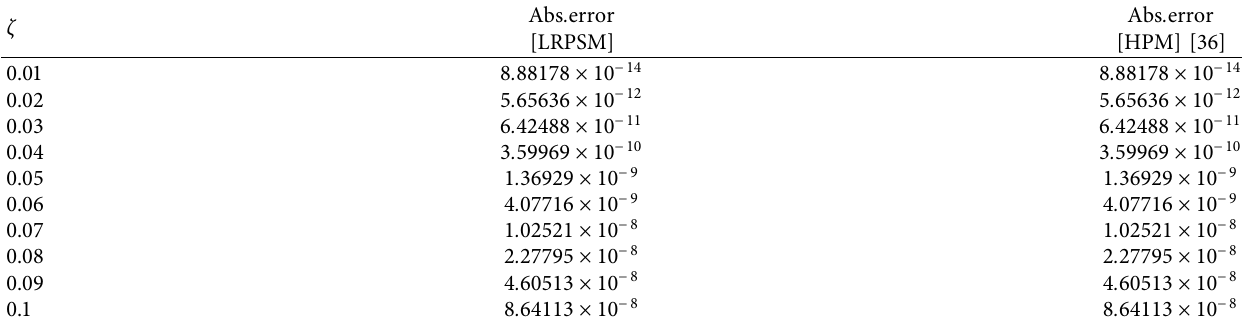
Table 15: | w ( ϰ , ζ ) − w 5 ( ϰ , ζ )| in diferent approaches for Problem 3 at ϰ � 1 . 0 and λ � 2 . 0 when ϖ � 1 . 0 at plausible locations in the range ζ ∈ [ 0 , 0 . 1 ]